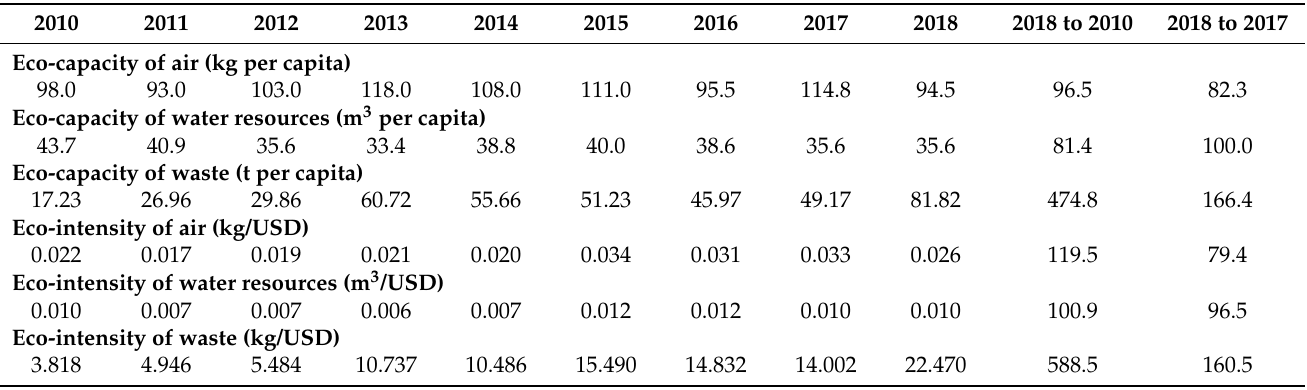
Table 2. Indicators of eco-capacity and eco-intensity of the Republic of Buryatia in